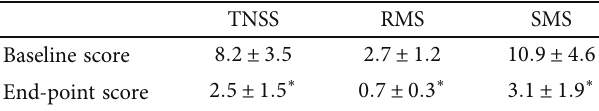
Table 2: Clinical e ffi cacy of allergen immunotherapy. TNSS RMS SMS Baseline